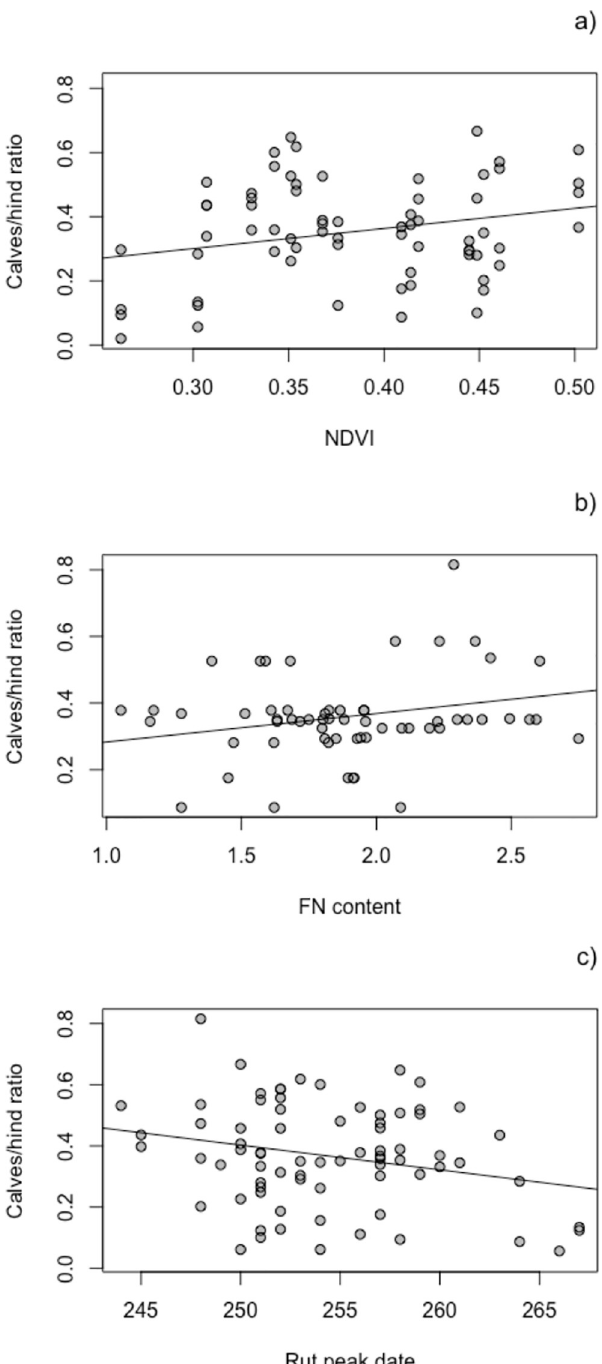
Fig 3. Model predictions for the effect of spring-summer NDVI (a), FN content (b) and rut peak date (c), on the percentage of calves per hind in the following year. Lines represent predictions from equations of models of Table 3, when the rest of variables were set at their mean values. Points are raw observed data.